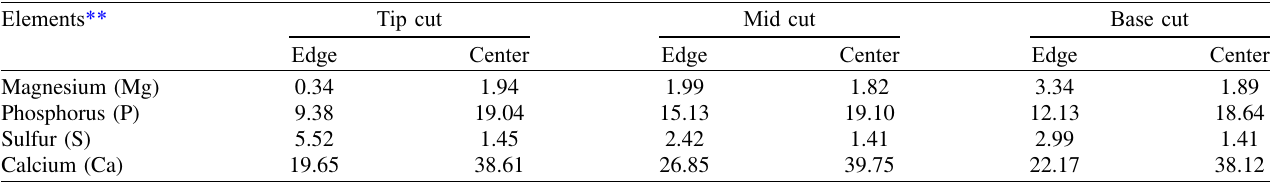
Table 5. Chemical composition of a small hook of Neoechinorhynchus personatus cut* at the three levels with a Gallium beam (LMIS) from a dual beam SEM.